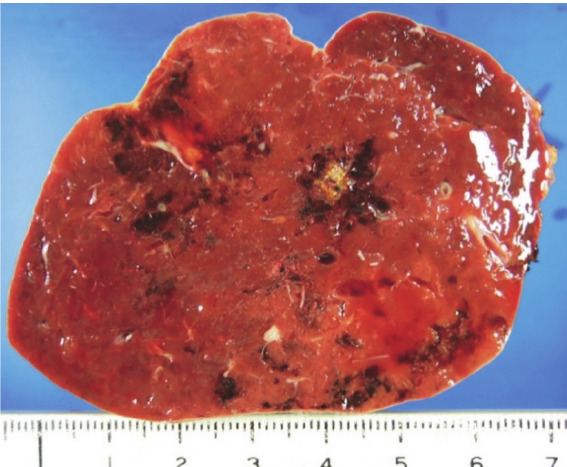
Figure 3: Cut surface of the resected specimen, showing some dark brown hemorrhagic spots, but no evidence of a tumor.